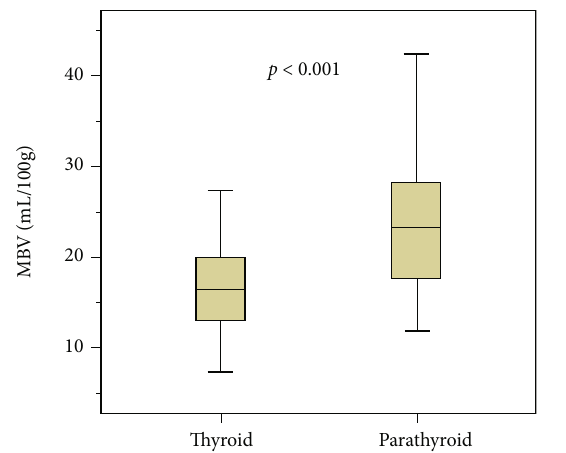
Figure 3: Boxplot. BV normal thyroid tissue vs BV parathyroid adenomas.